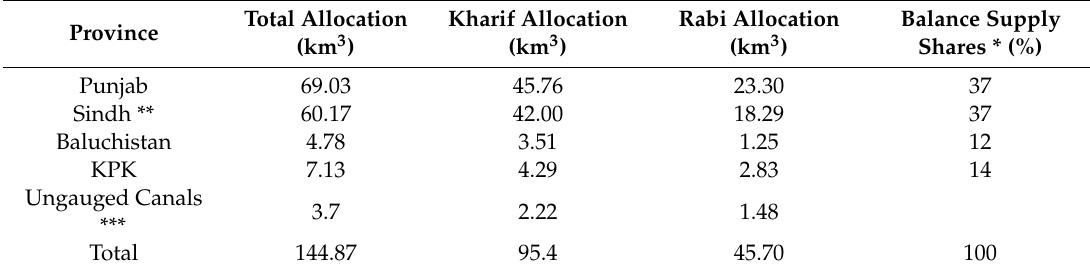
Table 1. Water allocation among the